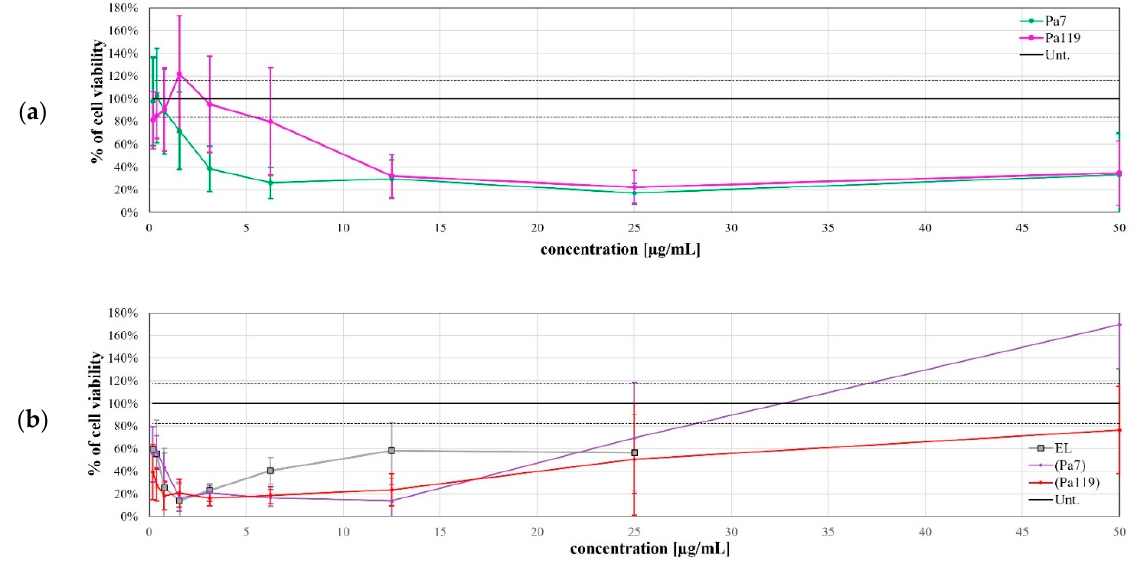
Figure 5. The bactericidal effect of the free ( a ) and encapsulated lysins ( b ) at 72 h post-treatment. The viability curve for the most effective time point (72 h p.t.) is shown. EL—empty liposomes; Pa7—free lysin Pa7 not encapsulated in liposomes; Pa119—free lysin Pa119 not encapsulated in liposomes; (Pa7)—encapsulated lysin Pa7 in liposomes; (Pa119)—encapsulated lysin Pa119 in liposomes; Unt.—untreated control. For both free lysins and encapsulated lysins, concentration refer to protein concentration applied; for empty formulation, concentration refers to the lipidic concentration tested to match the one used on encapsulated lysin application. The most effective concentration of the free lysins ( a ) is pointed with an orange arrow (25 µg/mL). The same is presented for encapsulated lysins ( b ) taking in consideration the effect of the empty formulations (6.25 µg/mL). The untreated control is shown as a black line, with the dashed lines representing the 95% confidence interval.